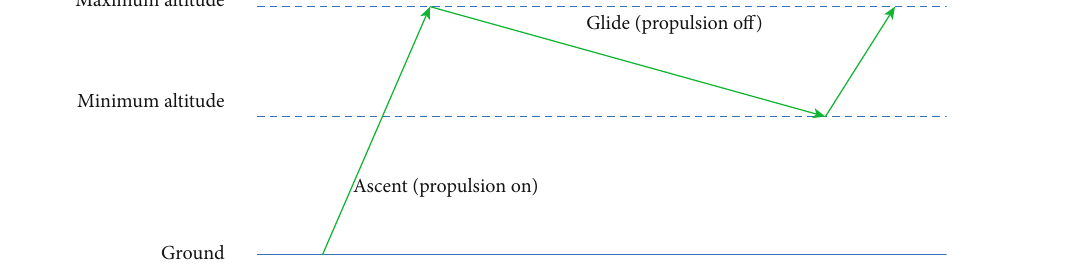
Figure 2: Flight mission of the UAV. Table 1: Weight estimation.